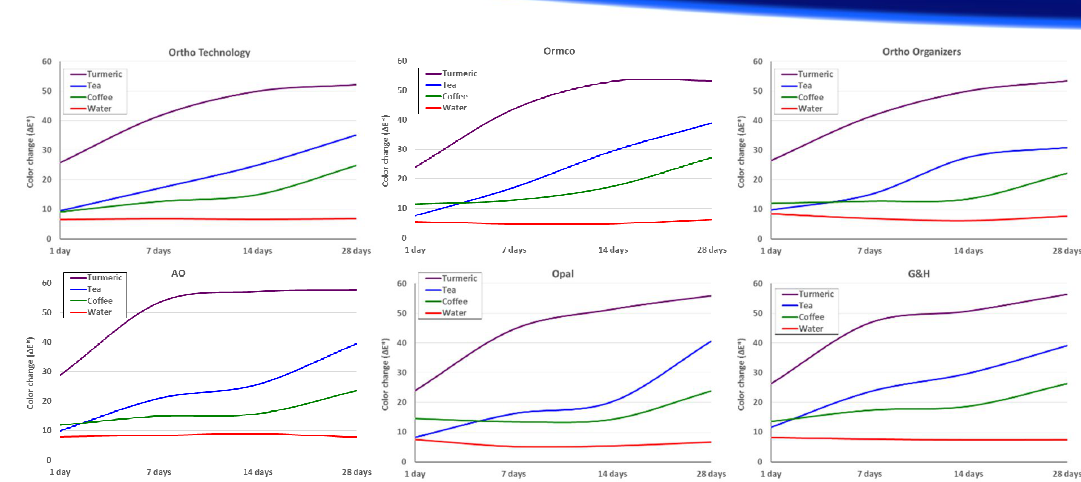
Figure 3: Mean color change of clear elastomeric chains from Ortho Technology, Ormco, Ortho Organizer, AO, Opal and G&H companies after immersion in water, tea, coffee, and turmeric.